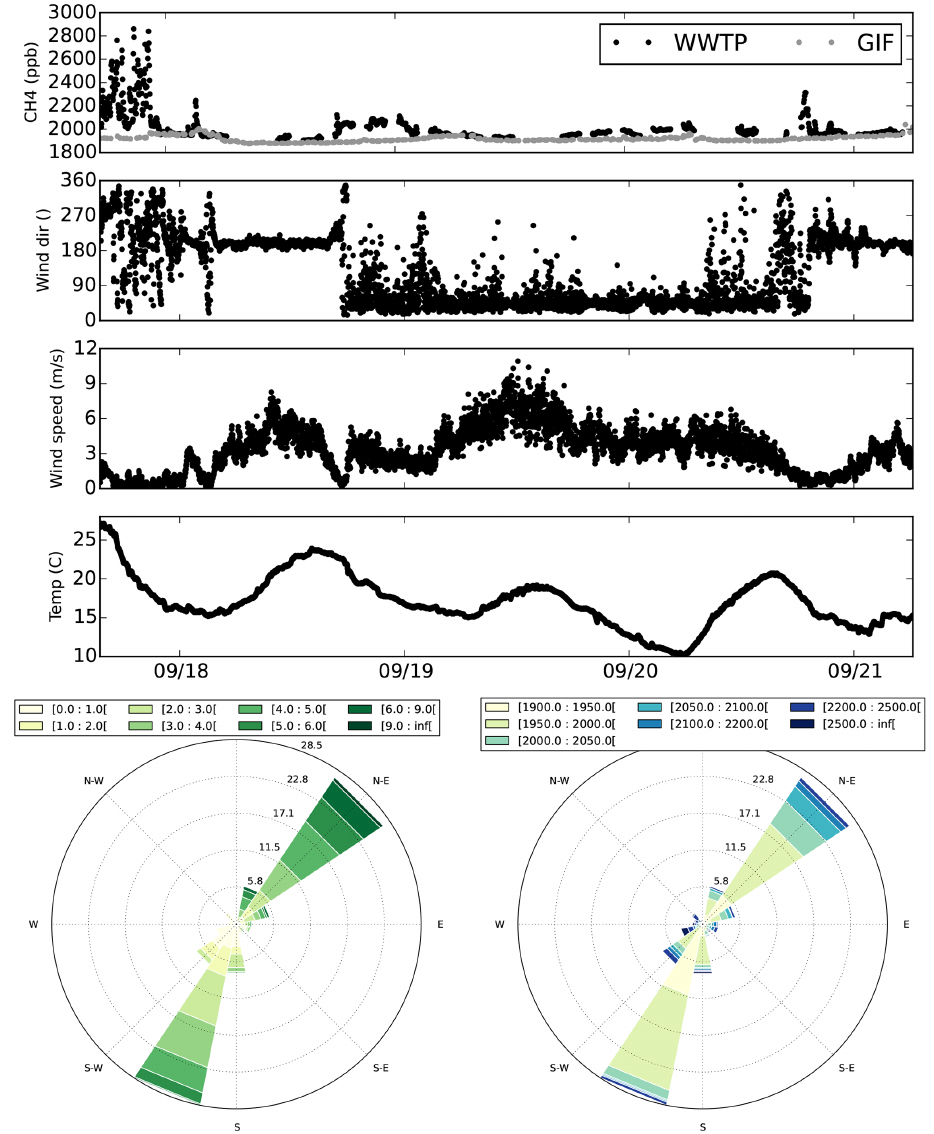
Figure 4. Upper panel: CH 4 concentrations from the LSCE FTIR analyzer at Valence and from the suburban station of Gif-sur-Yvette, wind speed, wind direction and temperature during the campaign. Lower panel: wind roses of the wind speed (ms − 1 ) and CH 4 concentration (ppb) during the